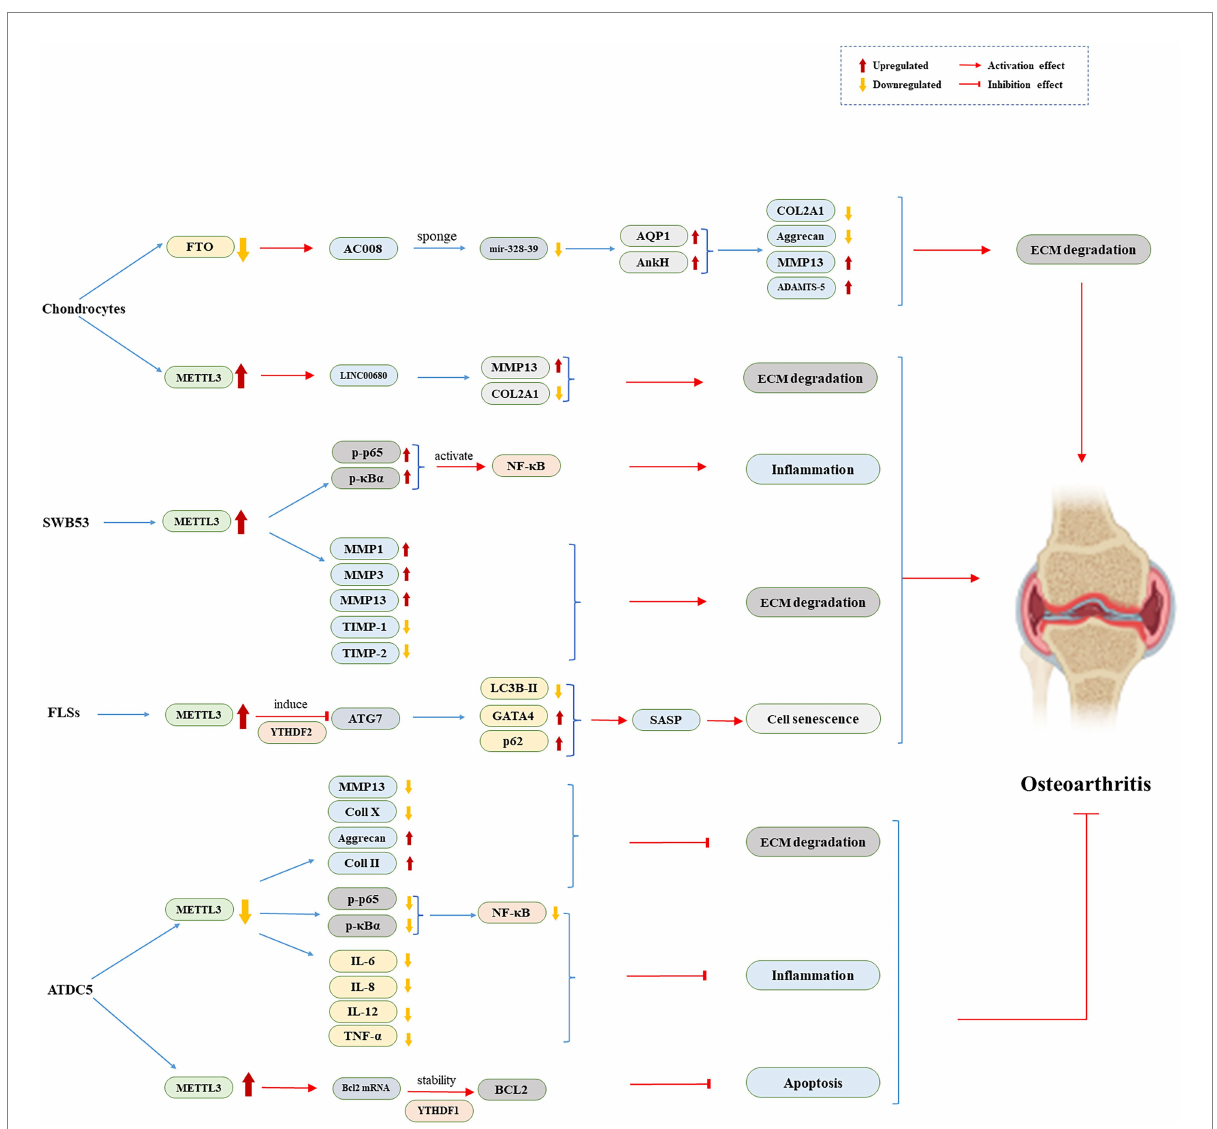
FIGURE 1 The role of m 6 A regulators in ATDC5, FLSs, SWB53, and Chondrocytes. ADAMTS-5, a disintegrin and metalloproteinase with thrombospondin motifs-5; ATG7, autophagy related protein 7; COL2A1, collagen type II alpha 1; Coll II, type II collagen; ECM, extracellular matrix; FLSs, fibroblast like synoviocytes; FTO, fat mass and obesity-associated protein; IL, interleukin; LC3B-II, microtubule-associated protein 1 light chain 3B-II; MMP, matrix metalloproteinase NF- κ B, nuclear factor- κ B; p-p65, phosphorylated-p65; TIMP, tissue inhibitors of metalloprotease; TNF- α , tumor necrosis factor alpha; YTHDF, YTH N 6 -methyladenosine RNA binding